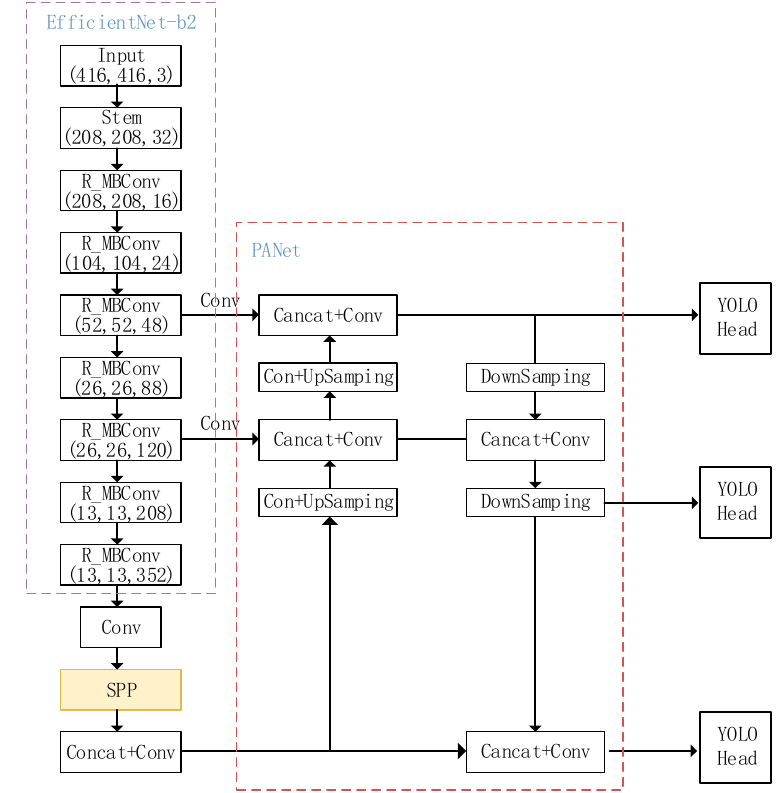
Figure 6. YOLO_EC network structure is proposed in this